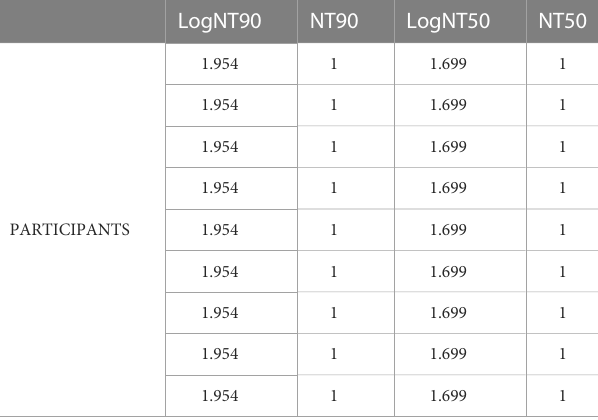
TABLE 3 SARS-CoV-2 directed IgG cross-reactive neutralizing antibody titres. Summarises the responses of nine participants tested for neutralising antibodies against